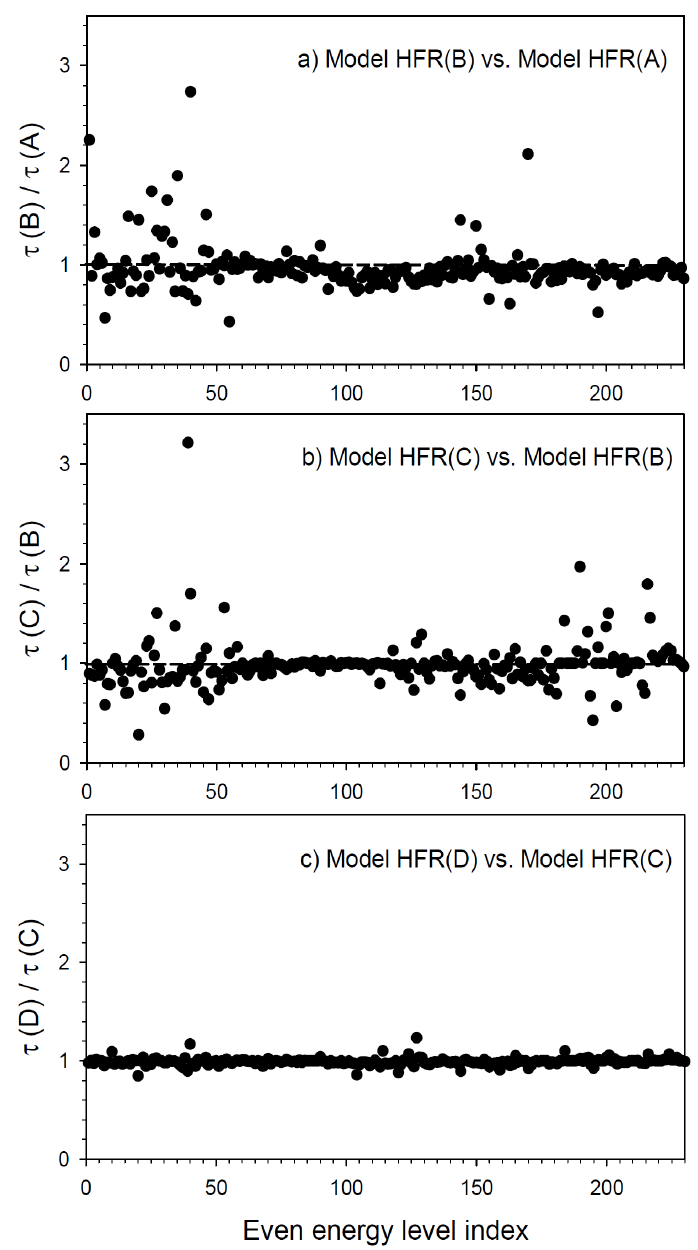
Figure 1. Comparison between radiative lifetimes obtained in the present work using different HFR models for short-lived even-parity energy levels ( τ < 100 ns) in W VIII. In each panel, the y-axis gives the ratio of τ -values computed with two successive models including only single excitations (see text) while the x-axis corresponds to the level indexes, assigned according to the order of increasing